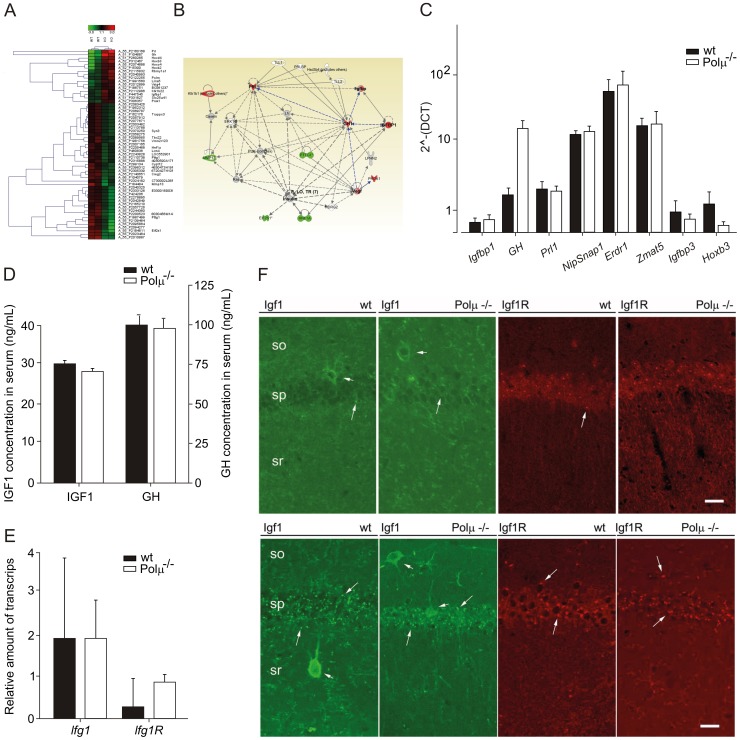
Polµ−/− mice brain presents an altered endocrine network.(A) Hierarchical clustering of the differential mRNA expression between wild-type and Polµ−/− old (18 months) mice. (B) Schematic representation of the expression network detected using the software Ingenuity. (C) qRT-PCR analysis of genes belonging to the previously described network (B) and others found in DNA expression arrays carried out with brain of acutely treated animals (Figure S10). Black bars denote values for wild-type animals and white bars correspond to Polµ−/− animals. (D) Circulating levels of IGF1 and GH (ng/mL) were monitored by ELISA in old (21–24 months) animals. (E, F) qRT-PCR expression (E) and immunoconfocal analysis (F) of Igf1 and Igf1R in the hippocampal CA1area from wild-type and Polμ−/− young adult (4 months) mice. Igf1 immunoreactivity-labeled non-pyramidal cells (short arrows) of stratum oriens (so), stratum pyramidale (sp), and stratum radiatum (sr; not shown); no differences in labeling frequency or labeling intensity were found between Polμ−/− and wild-type mice. Igf1R-immunostaining delineated cell processes in the stratum radiatum (sr) of Polμ−/− but not of wild-type mice. As compared with the case of aged mice, unspecific punctate labeling (long arrows) was infrequent in these tissue sections. Slight differences were found, however, in the occurrence of Igf1-immunoreactive cells in the CA1 area of aged mice, and in the expression of Igf1R between young wild-type and Polμ−/− mice. Scale bar, 25 µm.